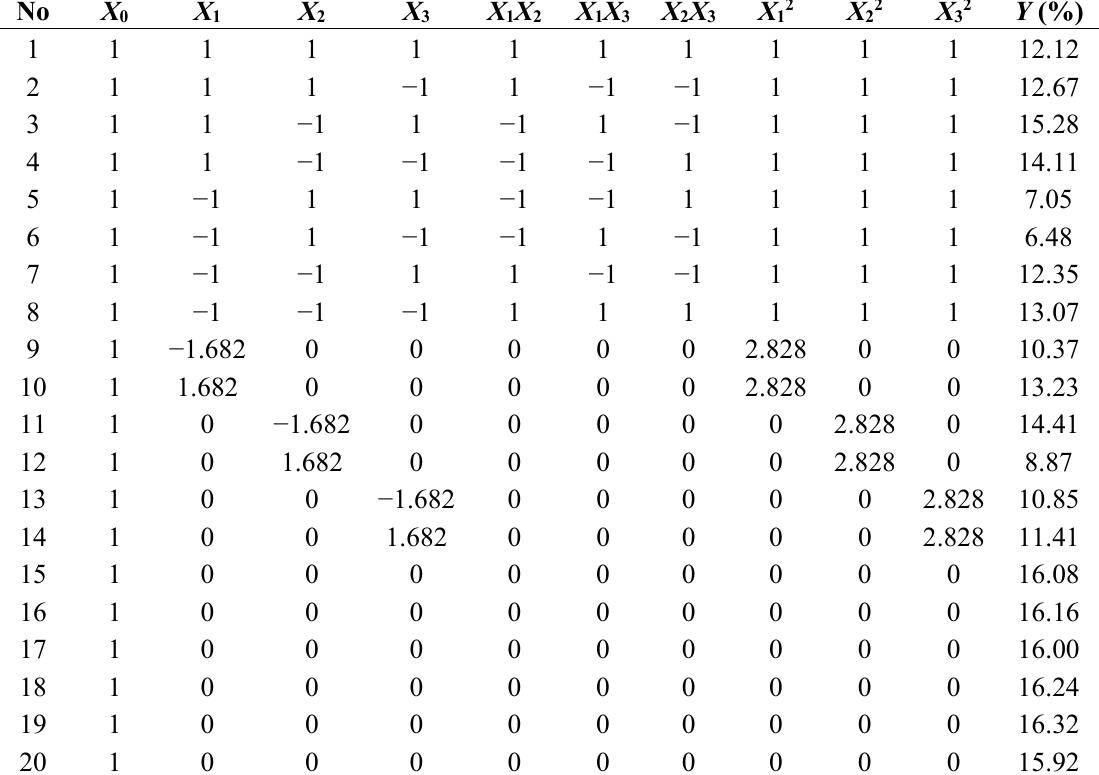
Table 1. The test scheme and its results in quadratic general rotary unitized design of areca seed.